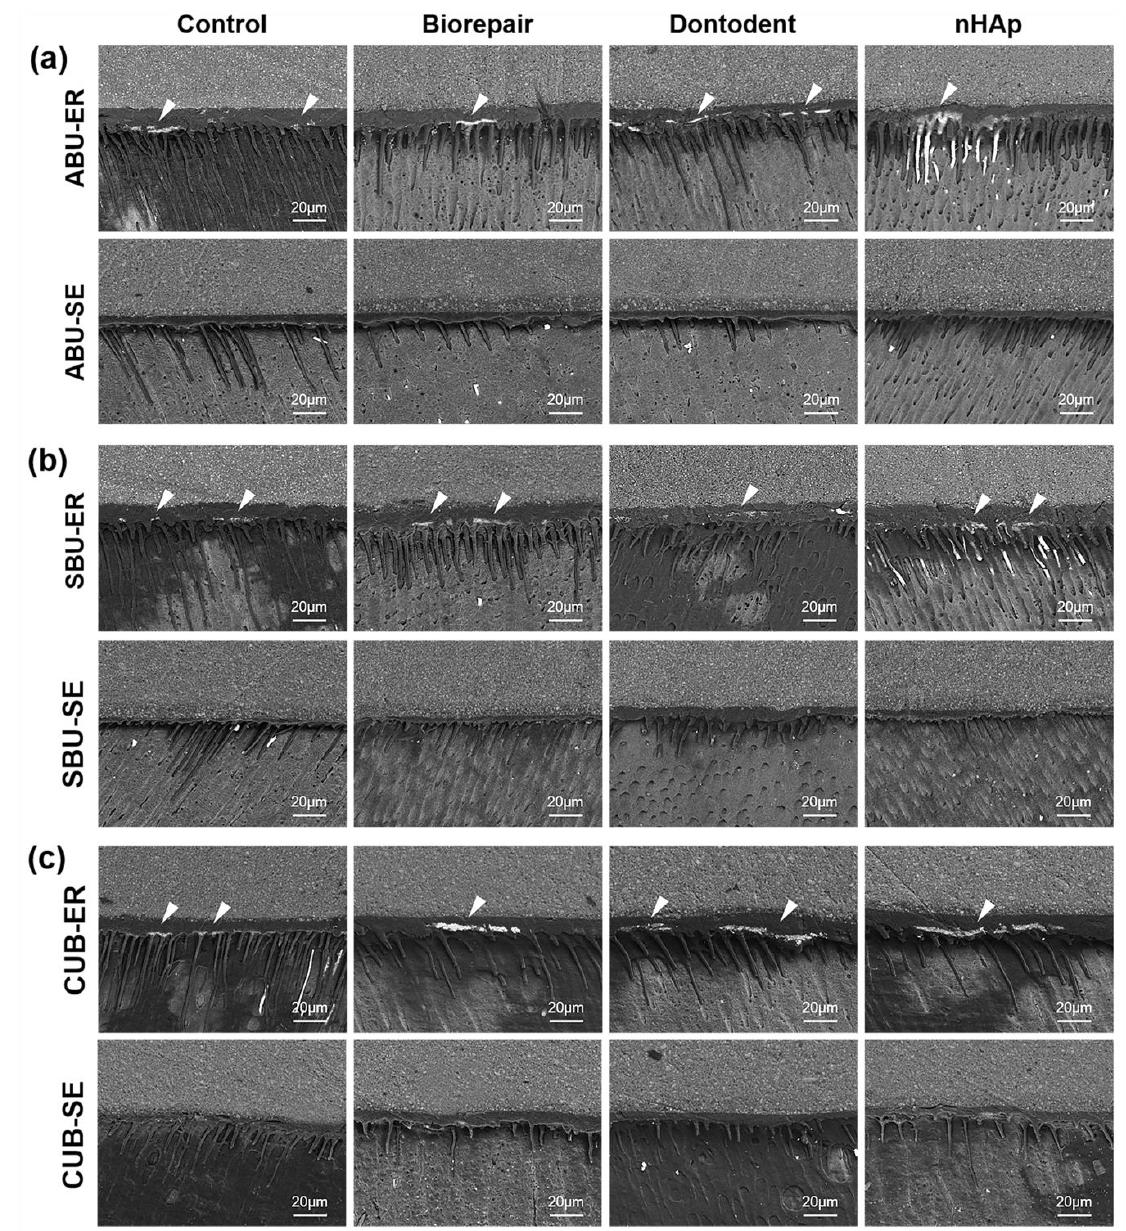
Figure 9. Nanoleakage within the resin – dentin bonding interfaces in etch-and-rinse mode or self-etch mode. ( a ) All-Bond Universal (ABU). ( b ) Single Bond Universal (SBU). ( c ) Clearfil Universal Bond (CUB). A silver-free zone distributed along adhesive interfaces in self-etch mode. Spotted silver deposits were restricted to the hybrid layer of etch-and-rinse mode. Solid arrowhead: nanoleakage indicated by silver deposits. ER: etch-and-rinse mode; SE: self-etch mode.